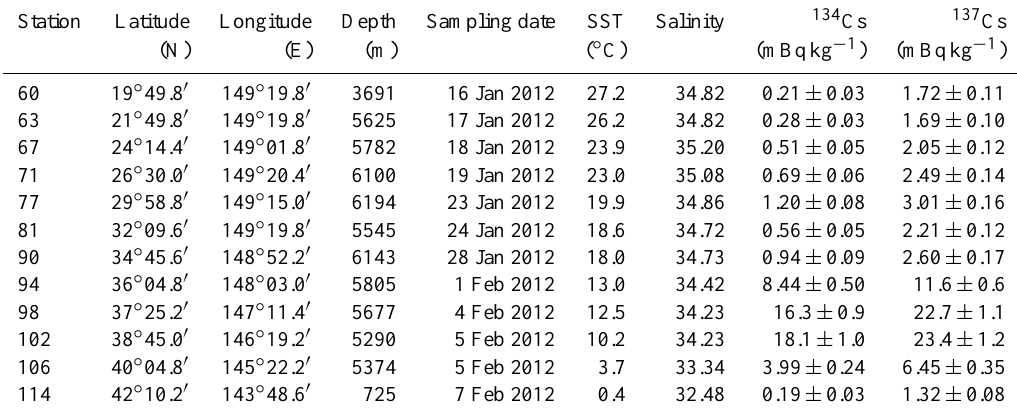
Table 2. Temperatures, salinities and radiocesium activities in surface seawater collected in western North Pacific Ocean 10 months after the FNPP1 accident. The radiocesium activities were decay corrected to the date of sampling. The uncertainty of radiocesium activity is the sum of errors due to the gamma counting, calibration, and cascade correction and is given at one sigma. SST means sea surface